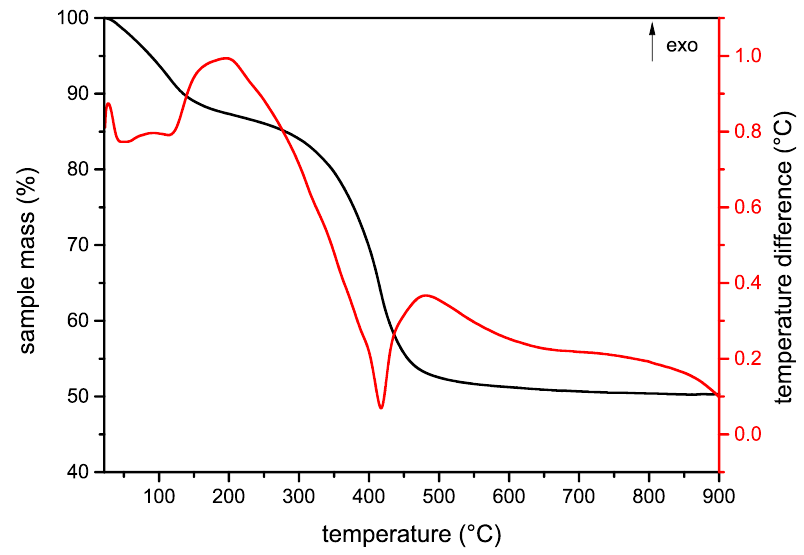
Figure 2. Thermogravimetric analysis-differential thermal analysis (TG-DTA) of sample MA–MnO4.